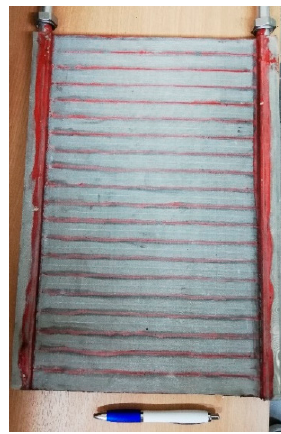
Figure 3. Tube–fin aluminum heat exchanger filled with activated carbon for a small-scale adsorption refrigerator, employing ethanol as the refrigerant [31].